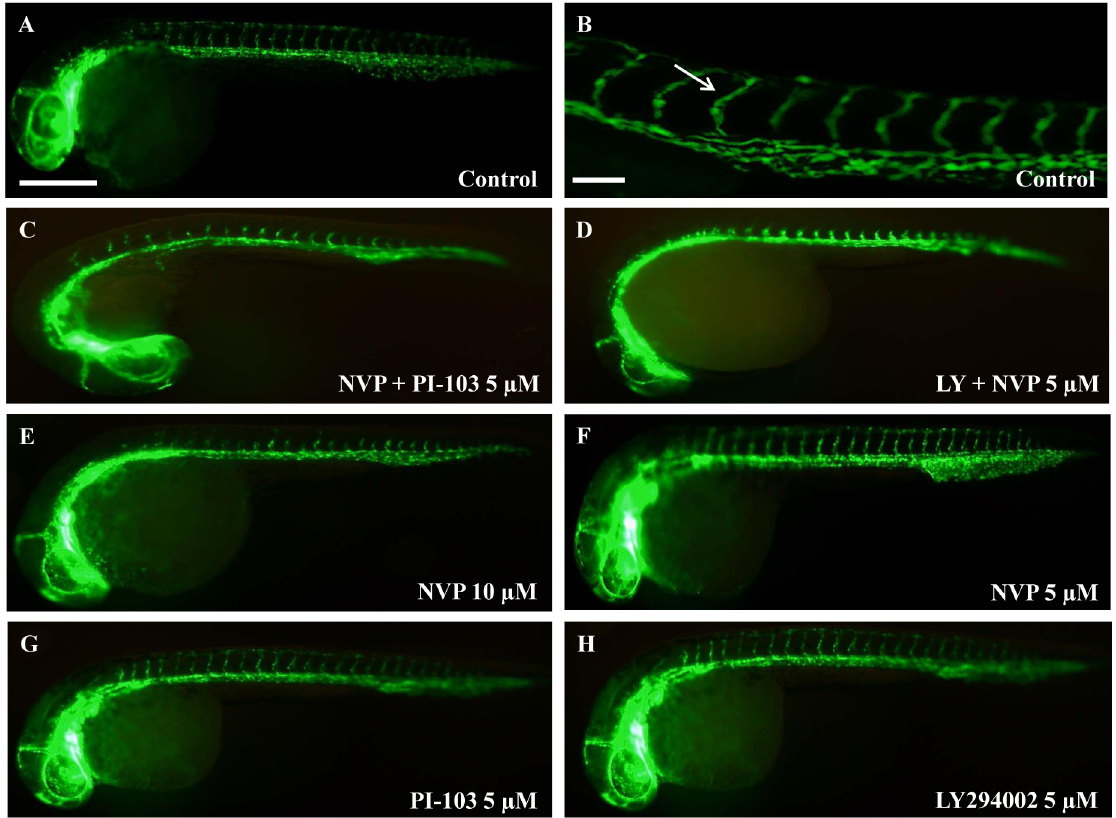
Figure 3. PI3K/Akt/mTOR inhibitors inhibit developmental angiogenesis of the intersegmental vasculature. Representative images demonstrating anti-angiogenic effects of PI3K/Akt/mTOR inhibitors on ISV development. In 0.1% DMSO-treated control larvae , 25 ISVs pairs develop (A) and high magnification (B). 5 m M NVP-BEZ235 + PI-103 (C), 5 m M LY294002 + NVP-BEZ235 ( D ) and 10 m M NVP-BEZ235 ( E ) exhibited significant anti-angiogenic effects compared to individual drugs at 5 m M (F–H). White arrows indicate the ISVs sprouting from the dorsal aorta (DA) to the dorsal longitudinal anastomic vessel (DLAV). Scale bar in A is 500 m m and in B is 100 m m ( B ). n=25–30.